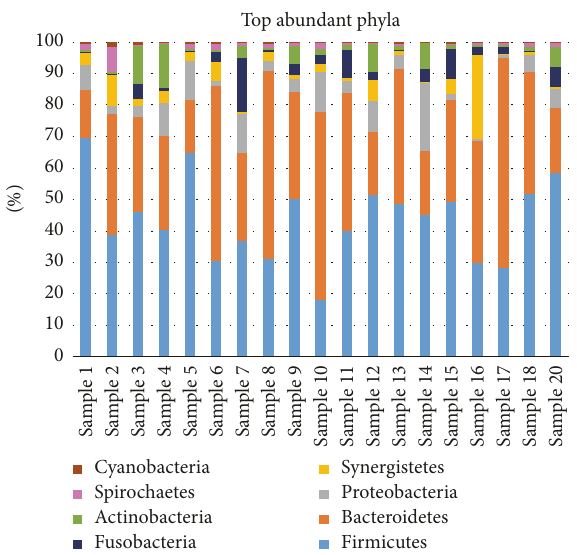
Figure 1: Relative abundance of the top most predominant bacterial phyla in each one of the 19 samples from the root canal content of endodontic infections. Data presented in average proportion (%) of all